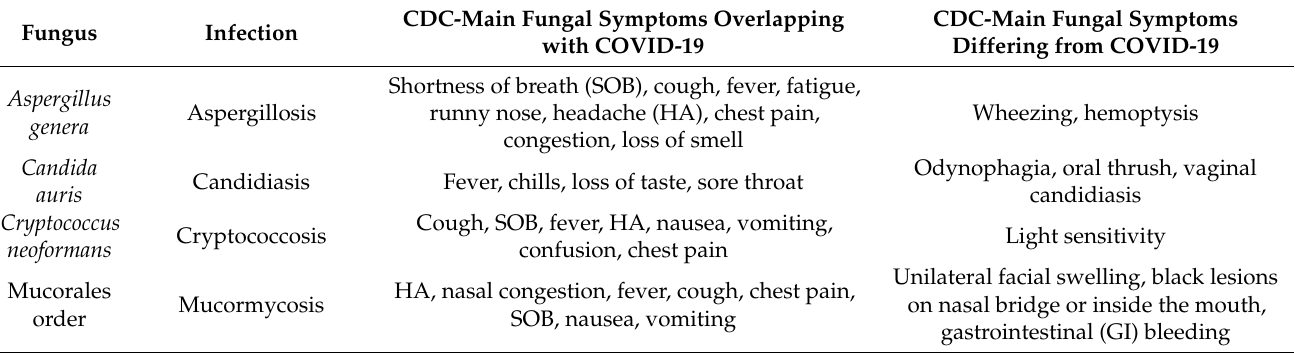
Table 1. Comparison of fungal infection and COVID-19 infection via analysis of overlapping and differing symptom presentations.